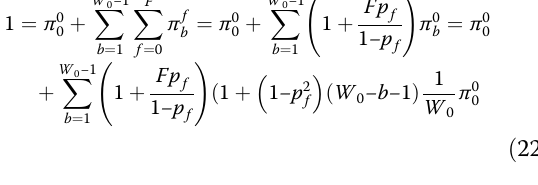
π 0 and the 0 as follows. 0